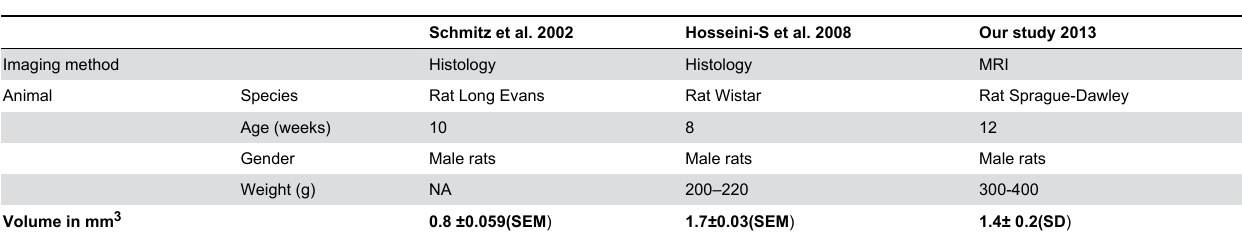
Table 4. Granule cell